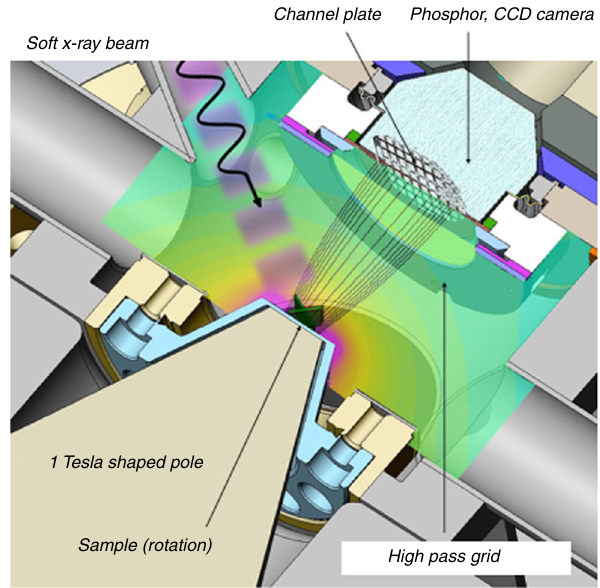
Fig. 2 Schematic of the NEXAFS microscope. The system uses magnetic projection electron imaging with a nearly 100% collection ef fi ciency and a large depth of fi eld, which allows the analysis of corrugated samples and sample rotation. Auger electrons are forced to follow the magnetic fi eld lines on helical orbits and analyzed by a grid energy analyzer and detected by phosphor screen and a CCD